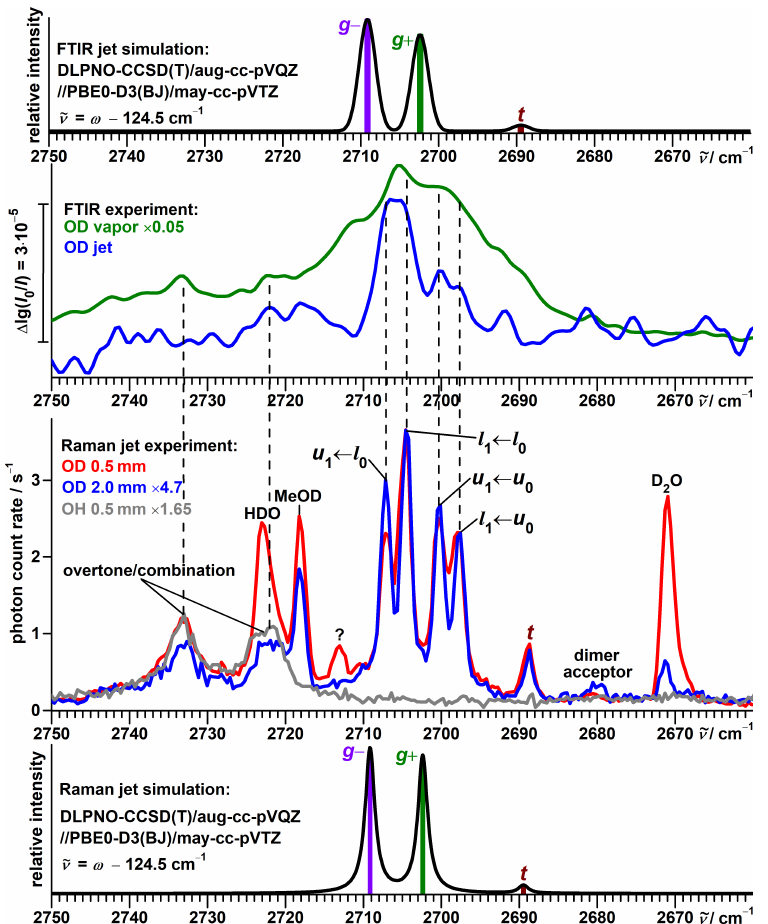
Figure 5. Top half: Comparison between simulated and experimental FTIR jet spectra of α -fenchol- OD. In addition, an FTIR spectrum of the vapor at ambient temperature is shown. Bottom half: Comparison between simulated and experimental Raman jet spectra of α -fenchol-OD at two different detection distances from the nozzle in the OD stretching region. In addition, a spectrum of α - fenchol-OH in this spectral region is shown. For the simulations, a Boltzmann distribution of localized conformers is assumed at a conformational temperature of 100 K. Harmonic OD stretching wavenumbers are uniformly shifted according to the model of Ref.